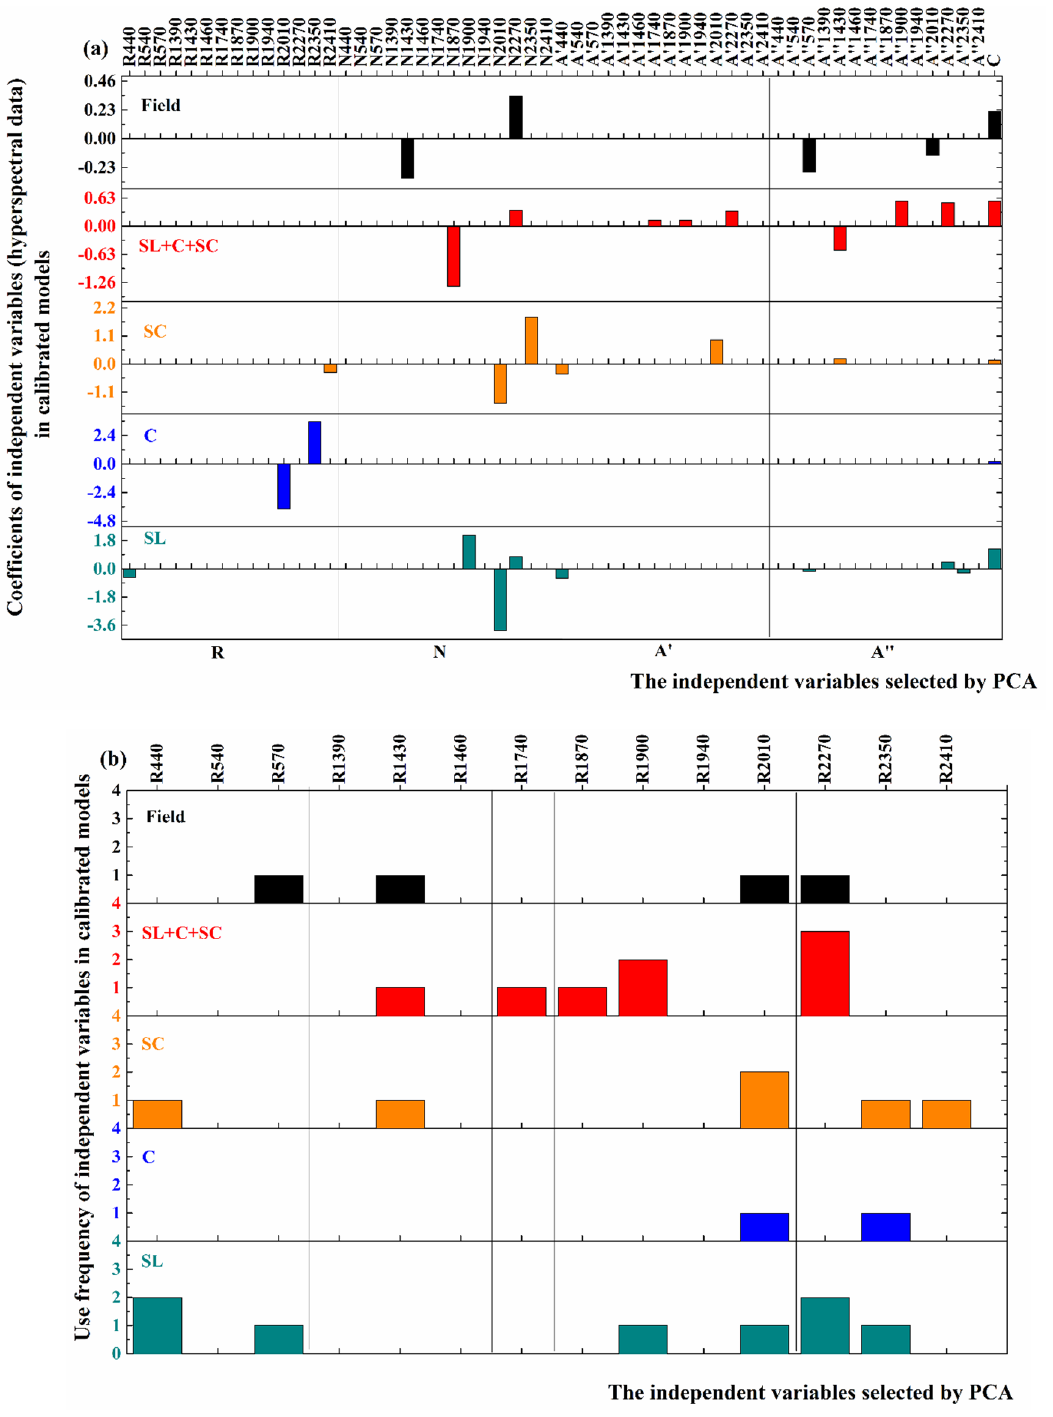
Figure 5. Bar graphs for ( a ) coefficients of M_SMC models for soil moisture content, where C (last variable on the X-axis in ( a ) is a constant in the models; and ( b ) use frequency of the coefficients in different zone.